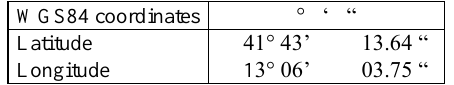
Table 1. WGS84 Coordinates of the site